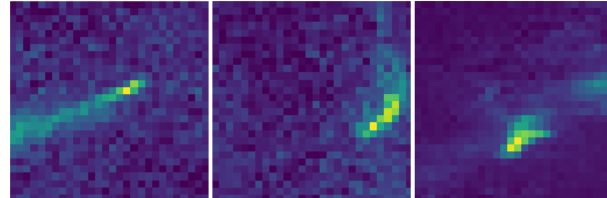
Figure 2. Three examples of individually normalized images of TROPOMI tropospheric column NO 2 that contain a